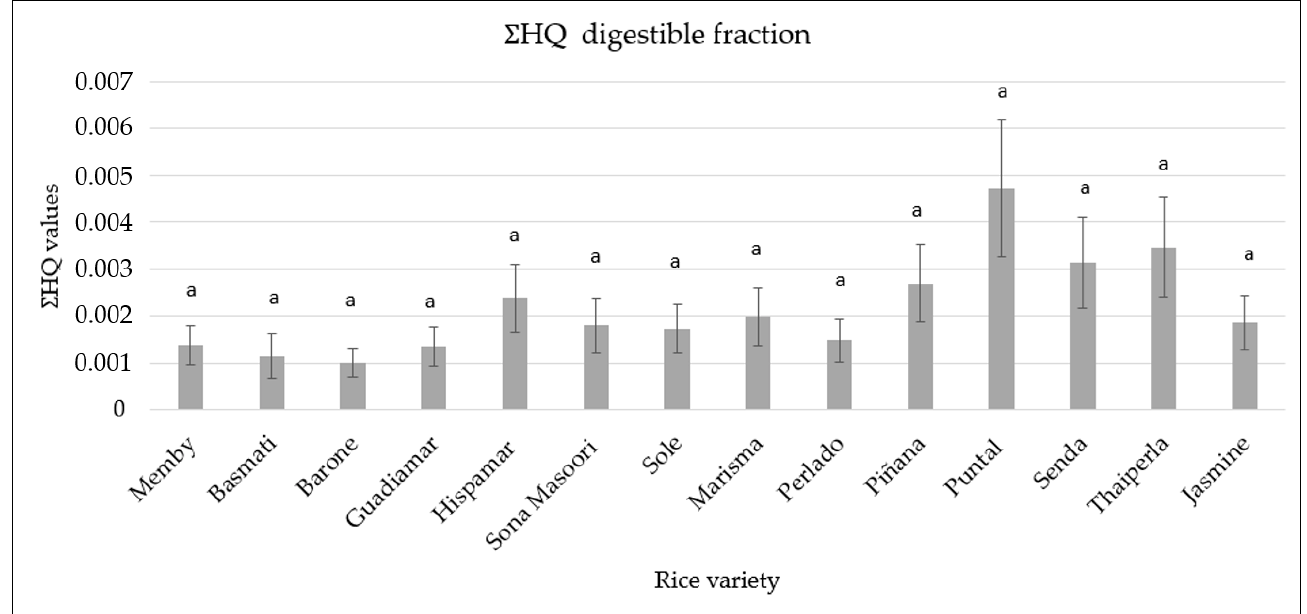
Figure 4. Total Hazard Quotient ( ∑ THQ) of digestible fraction. Different letters in the same row indicate significant differences by ANOVA test ( p < 0.05).